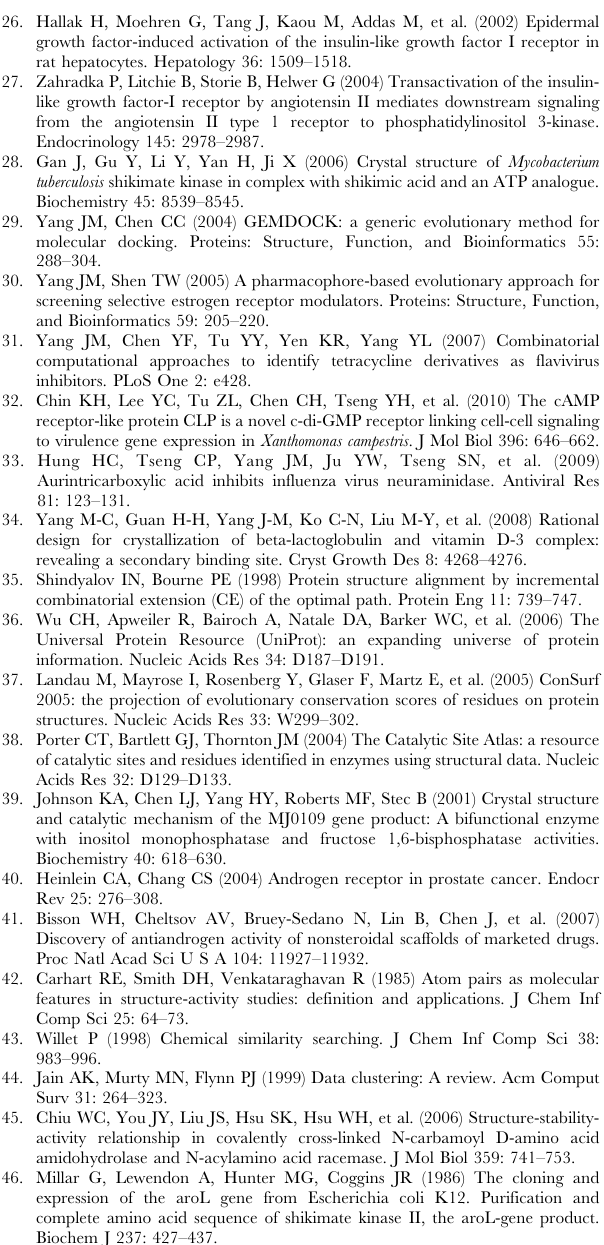
Table S2 Atom types used for atom pair descriptors. Table S3 Parameters used in the